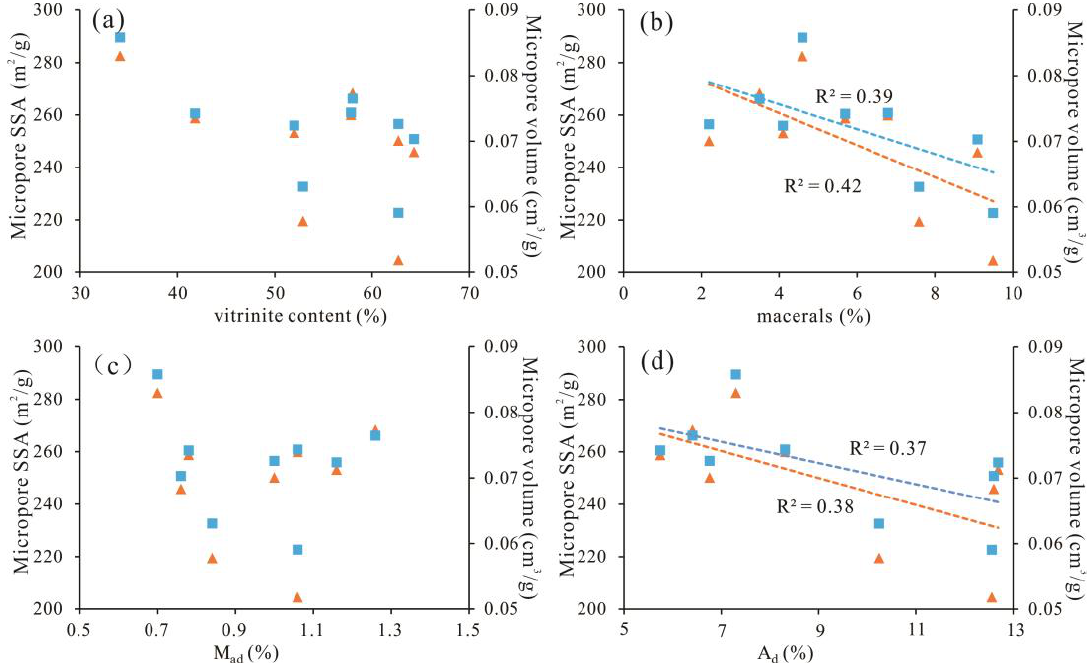
Figure 12. Relationships between the micro-PV, micro-SSA and ( a ) vitrinite content, and ( b ) macerals, ( c ) M ad , and ( d ) V d .